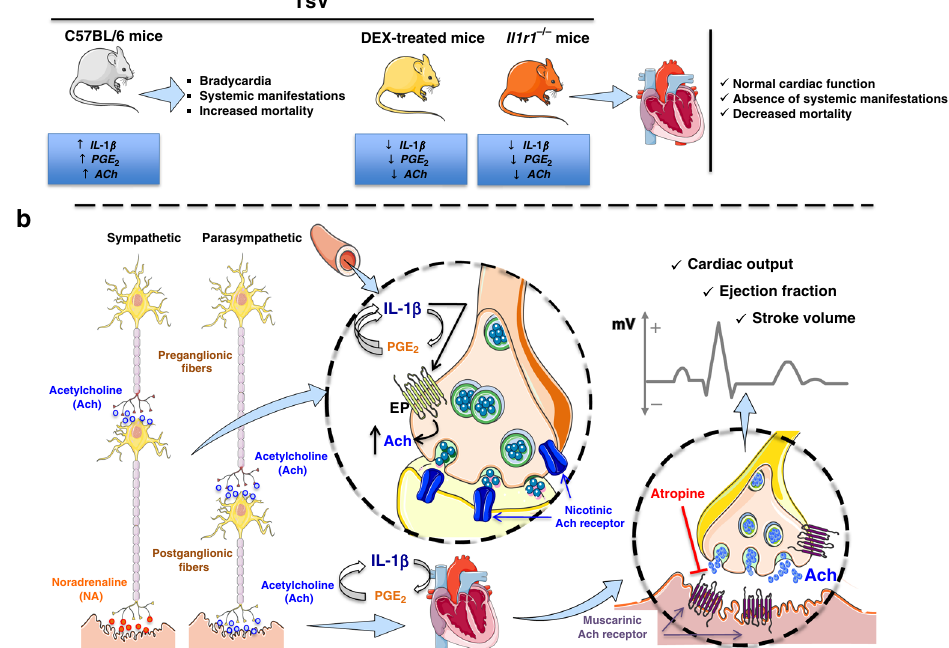
Fig. 6 Molecular mechanism linking IL-1R-PGE2-ACh axis to cardiac dysfunction. A lethal dose (180 μ g kg − 1 ) of scorpion venom (TsV) induces PGE 2, IL- 1 β , and ACh, resulting in cardiac dysfunctions and death. PGE 2 via the EP2/4 receptor induces ACh release through either pre-ganglionic fi bers of the sympathetic system or pre- and post-ganglionic fi bers of the parasympathetic system, which cause decreases in the heart ejection fraction, stroke volume, and cardiac output. Additionally, PGE 2 -EP2/EP4 ampli fi es IL-1 β production, which in turn, binds to the IL-1R and potentiates PGE 2 and ACh. IL-1R ( Il1r1 − / − ) de fi ciency or a high dose of DEX blocks PGE 2, IL-1 β , and ACh release and protects mice from cardiac dysfunction and mortality. Antagonism of muscarinic receptors by atropine and vagotomy prevent the cardiac alterations typically observed during severe scorpion